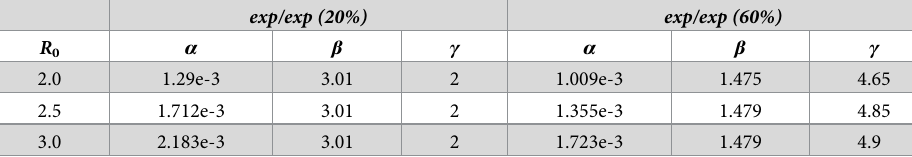
Table 1. Calibrated values of the parameters for the shedding